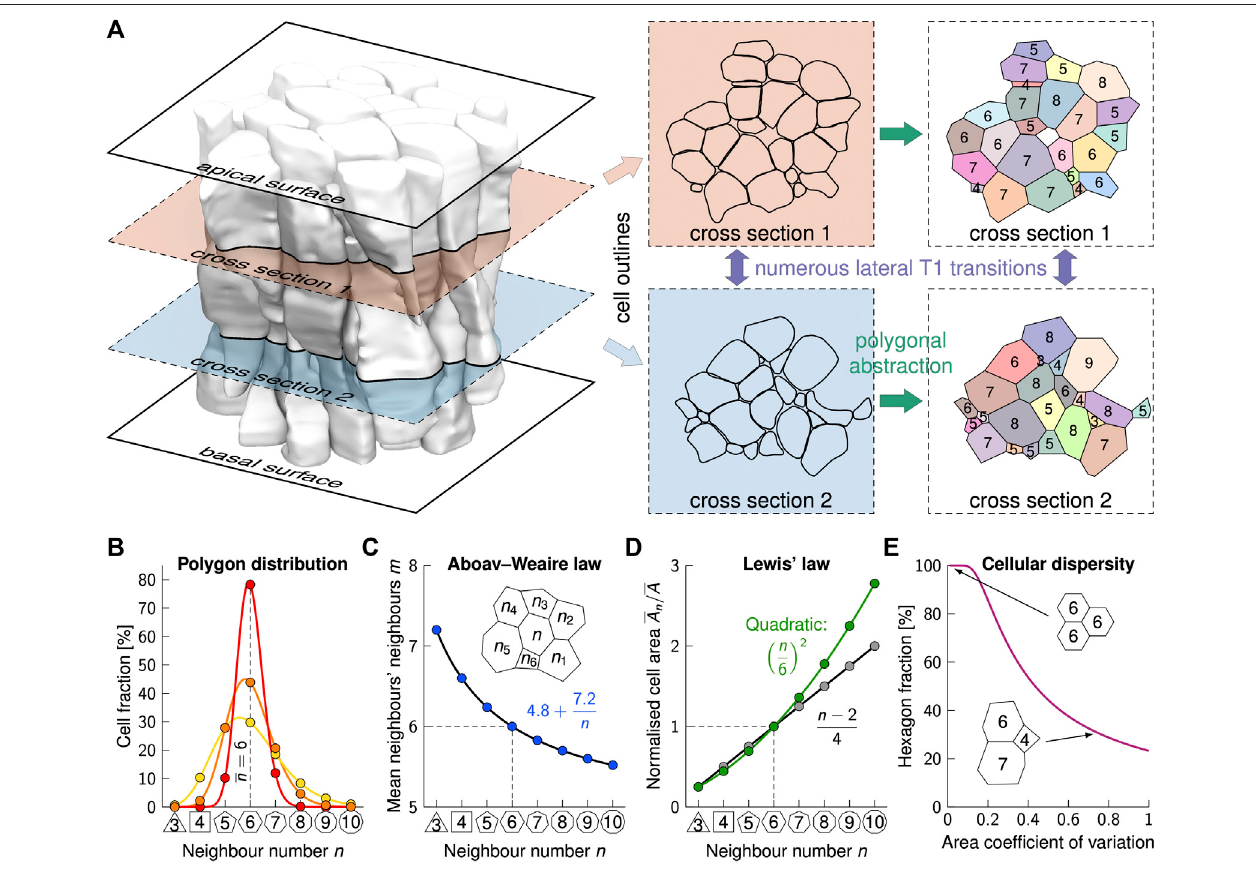
FIGURE 2 | Phenomenological laws in epithelial cell arrangements. (A) Slicing through a mouse embryonic lung epithelium (shaded cells [18]) repeatedly along the apical-basal axis reveals the complex shape and packing structure of punakoids. Even over short distances, numerous T1L transitions occur, leading to vastly different cellneighbourships.Coloursinthelastcolumnindicatecellidentity,valuesarecross-sectionalneighbournumbers. (B) Theaverageneighbournumber, (cid:1) n ,is(closeto)six in all epithelia, even though the hexagon fraction and the neighbor number distribution vary. (C) All quanti fi ed epithelial tissues follow Aboav-Weaire ’ s law. (D) All quanti fi ed epithelial tissues follow either Lewis ’ law (grey line), or the quadratic law (green line), or lie in between. (E) The hexagon frequency declines for increasing area variability according to the magenta curve.